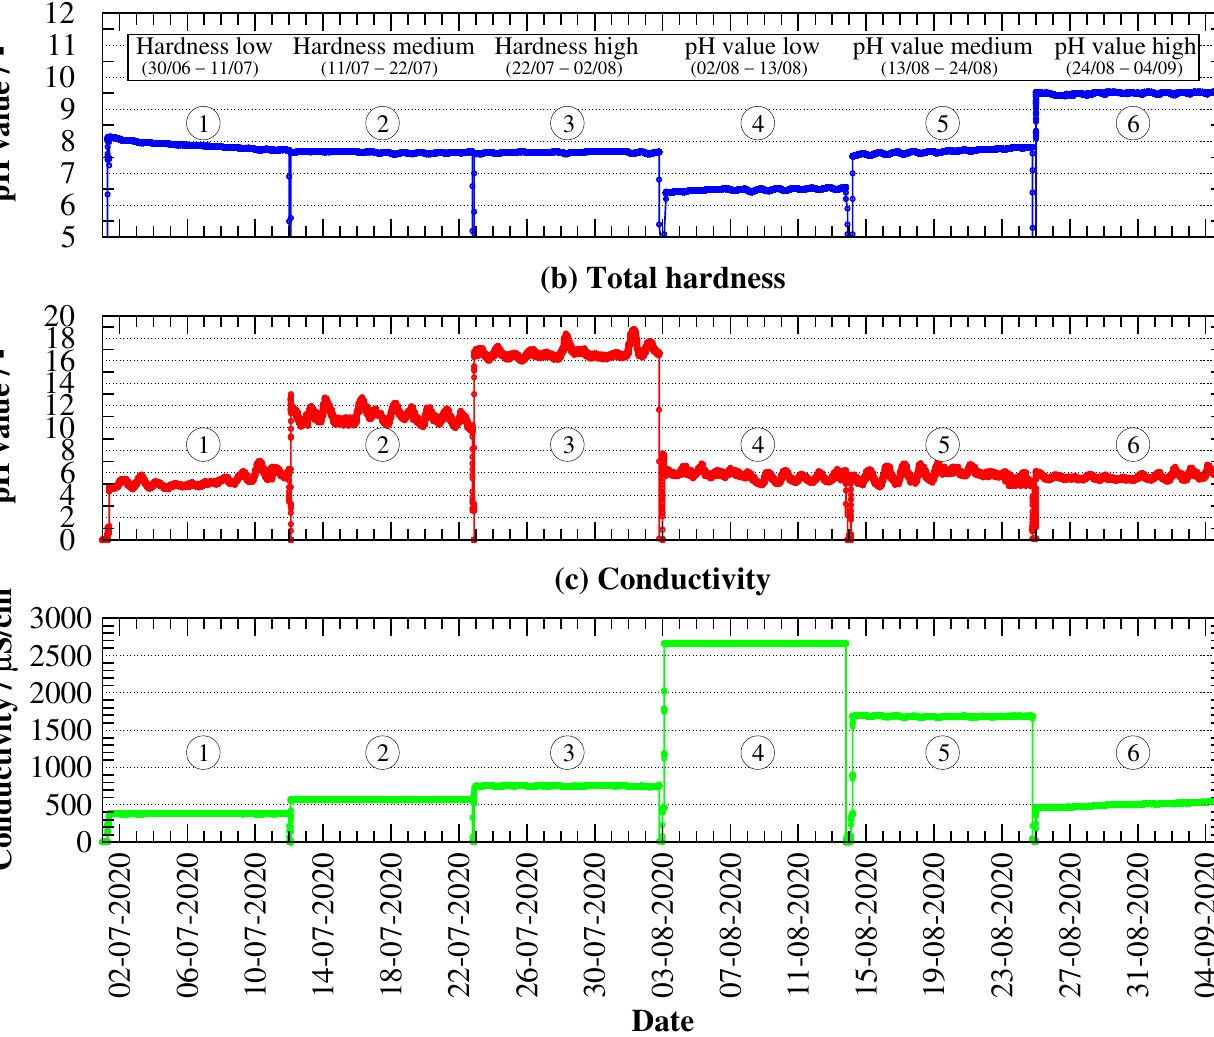
Figure 7. The logged data (pH value, hardness and conductivity) from the WA-control during the accelerated wear